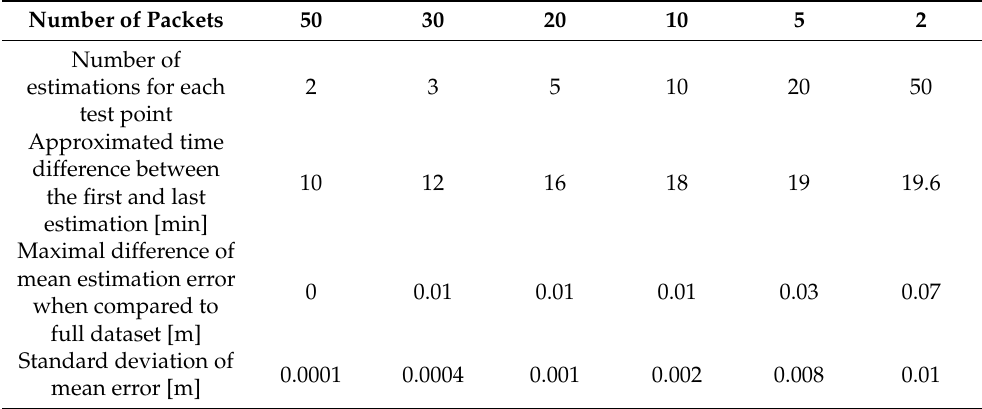
Table 6. Deviation of mean estimation error results calculated for a reduced number of RSS